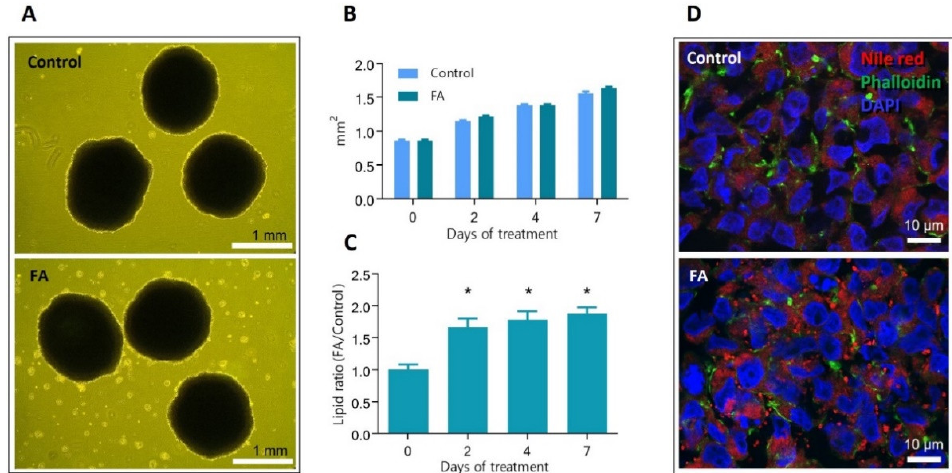
Figure 2. The effect of 45 µ M palmitic acid and 65 µ M oleic acid on spheroids growth and induced intracellular accumulation of lipids. FA—spheroids treated with 45 µ M palmitic acid and 65 µ M oleic acid, Control—spheroids in standard growth media. ( A ) 28 days old spheroids were maintained in growth media (upper panel) and after 7 days of FA supplementation (lower panel). Light microscopy images. ( B ) The growth of spheroids exposed to FA supplementation or Control media is determined by measuring spheroids’ planar surface. No statistically significant difference was observed between the Control and FA-treated spheroids at any time ( n = 21, p < 0.05). ( C ) Relative intracellular lipid levels in FA-treated and non-treated spheroids at day 0 (before treatment), 2, 4 and 7. * indicate statis- tical significance between Control and FA spheroids at respective timepoint ( n = 5, p -value < 0.05). ( D ) Fluorescent microscopy images of cryo-sectioned spheroids stained for DNA (blue), Lipids (red), and f-actin (green). Error bars show the standard error of the